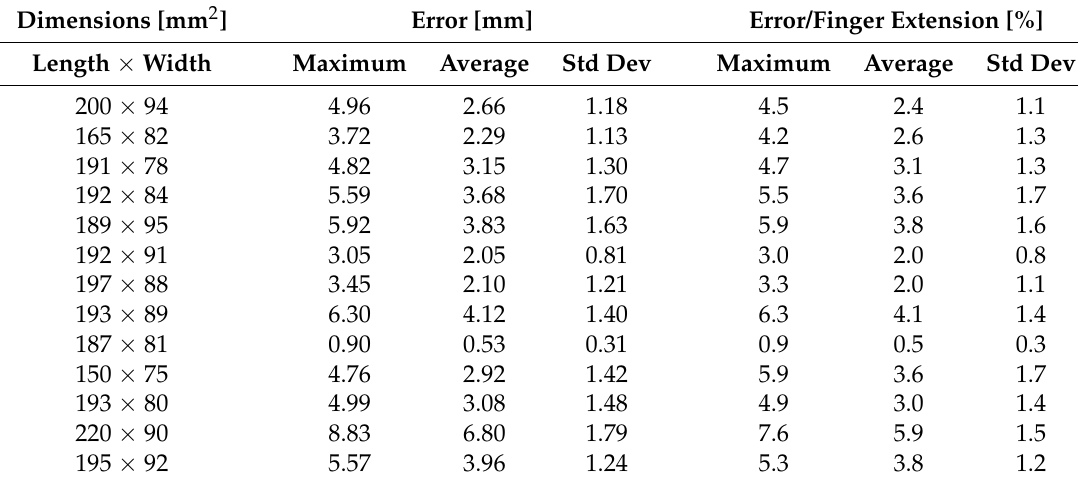
Table 1. Length and width of the hand, maximum, average and standard deviation (Std Dev) of the error between the desired and the real trajectory for the index finger, and maximum, average and standard percentage error expressed with respect to the subjects’ finger